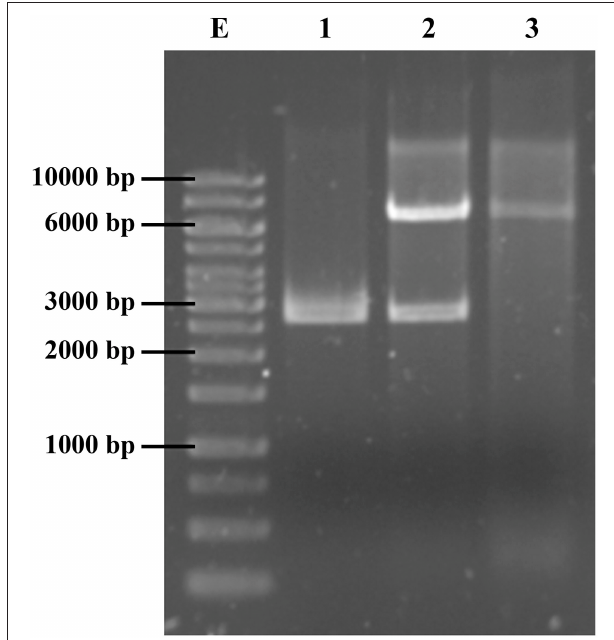
FIGURE 2 | Isolation of plasmid pABC-3, harboring the dfrA14 gene. Lane 1, pUC19 digested with Hin dIII. Lane 2, pCLON3, recombinant pUC19 harboring a ∼ 7kb fragment TMP-resistance marker, digested with Hin dIII. Lane 3, the native pABC-3 plasmid reconstituted by self-ligation and recovered from DH5 α TMP R transformants, digested with Hin